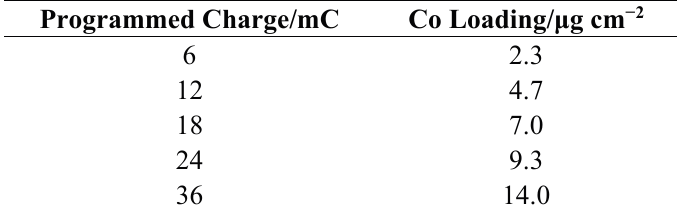
Table 1. The deposited charges of cobalt and the corresponding amount expressed in μ g cm − 2